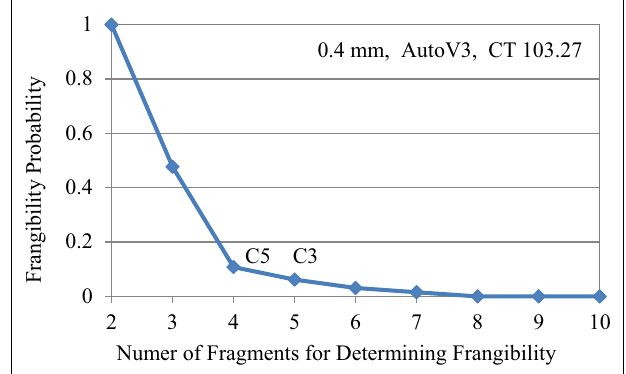
FIGURE 3 | The calculated frangibility probability as a function of number of fragments